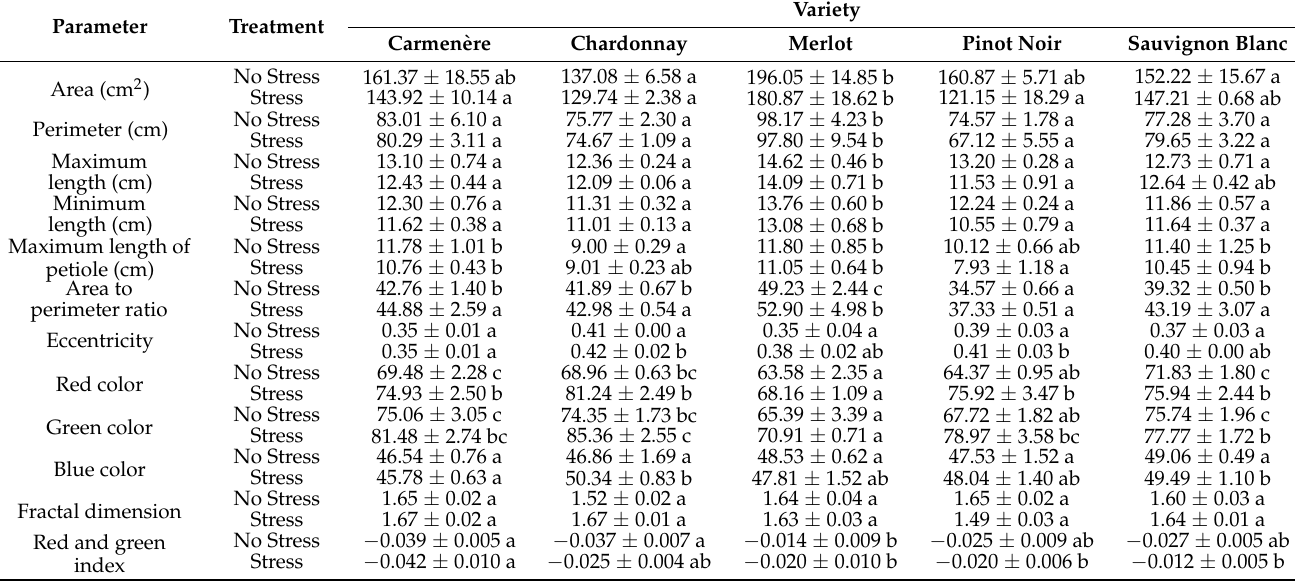
Table 2. Mean values for the leaf morpho-colorimetric features obtained by scanning leaves from five different grapevine varieties under stress and no stress